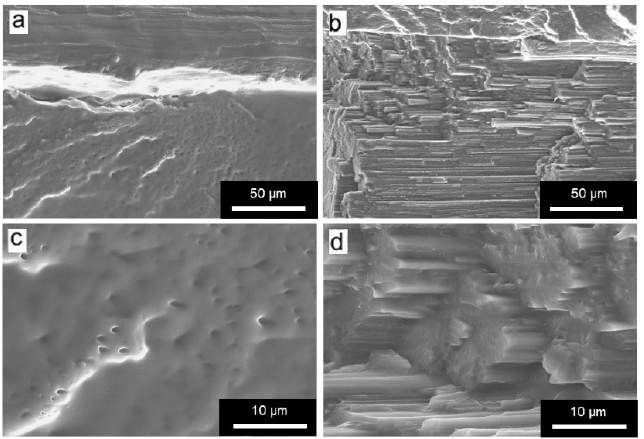
Figure 9. SEM micrographs of printed specimens of ( a ) and ( c ) FOMM t; ( b ) and ( d ) wFOMM. Scale bar ( a ) and ( b ) = 50 μ m; ( c ) and ( d ) = 10 μ m.